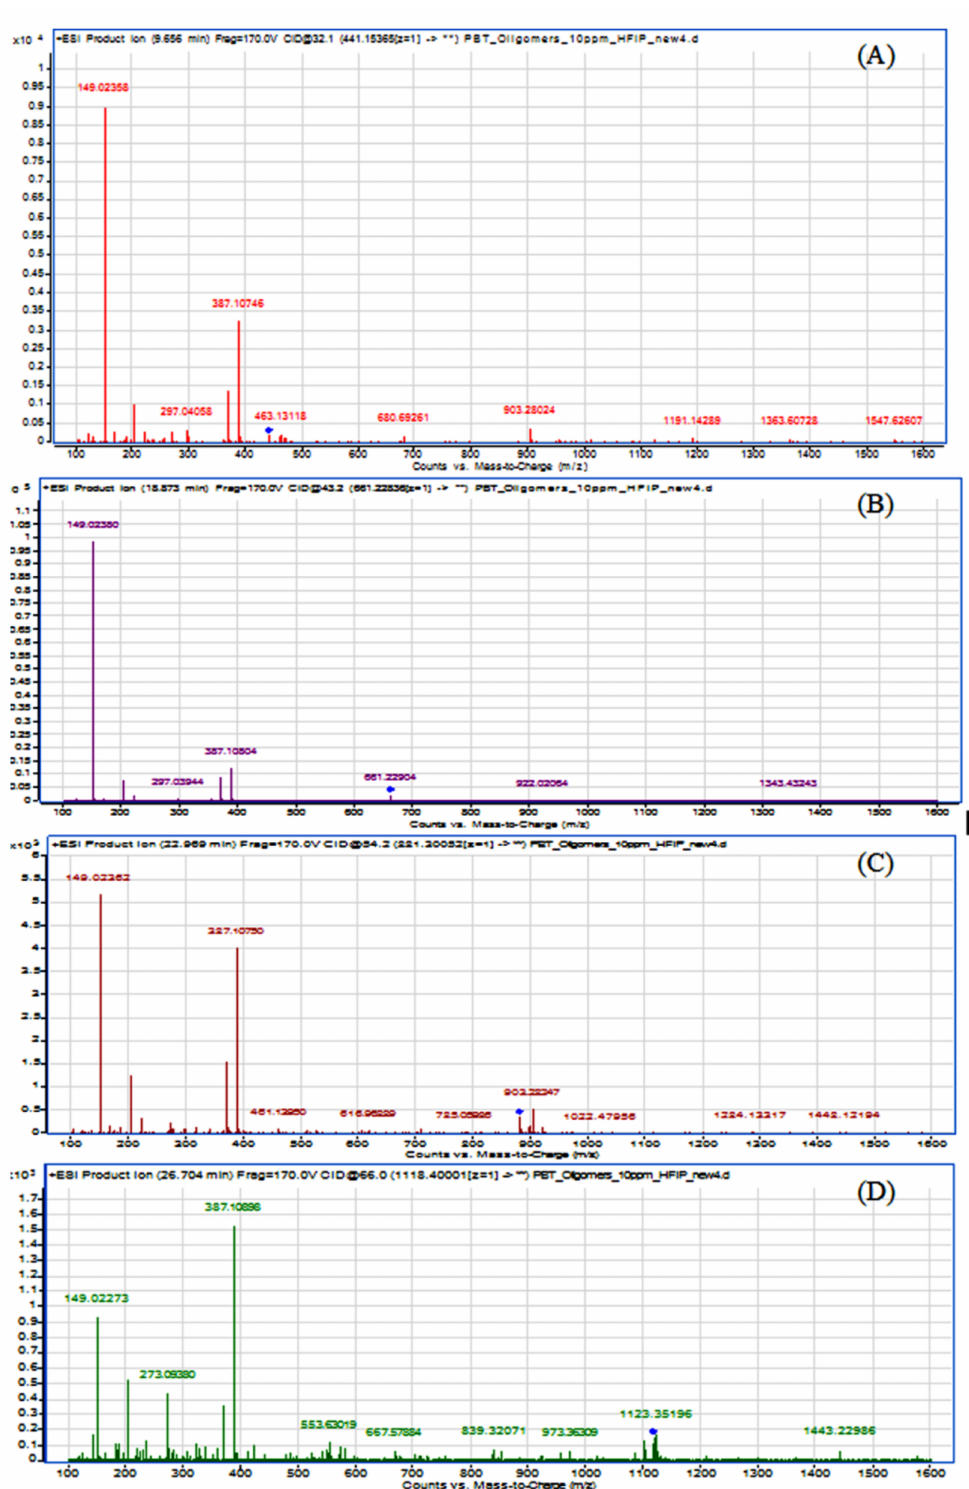
Figure 4. Acquired HR-MS 2 spectra of the PBT cyclic oligomers ( A ) dimer; ( B ) trimer; ( C ) tetramer and ( D ) pentamer. Precursor ions for each oligomer have been flagged with blue